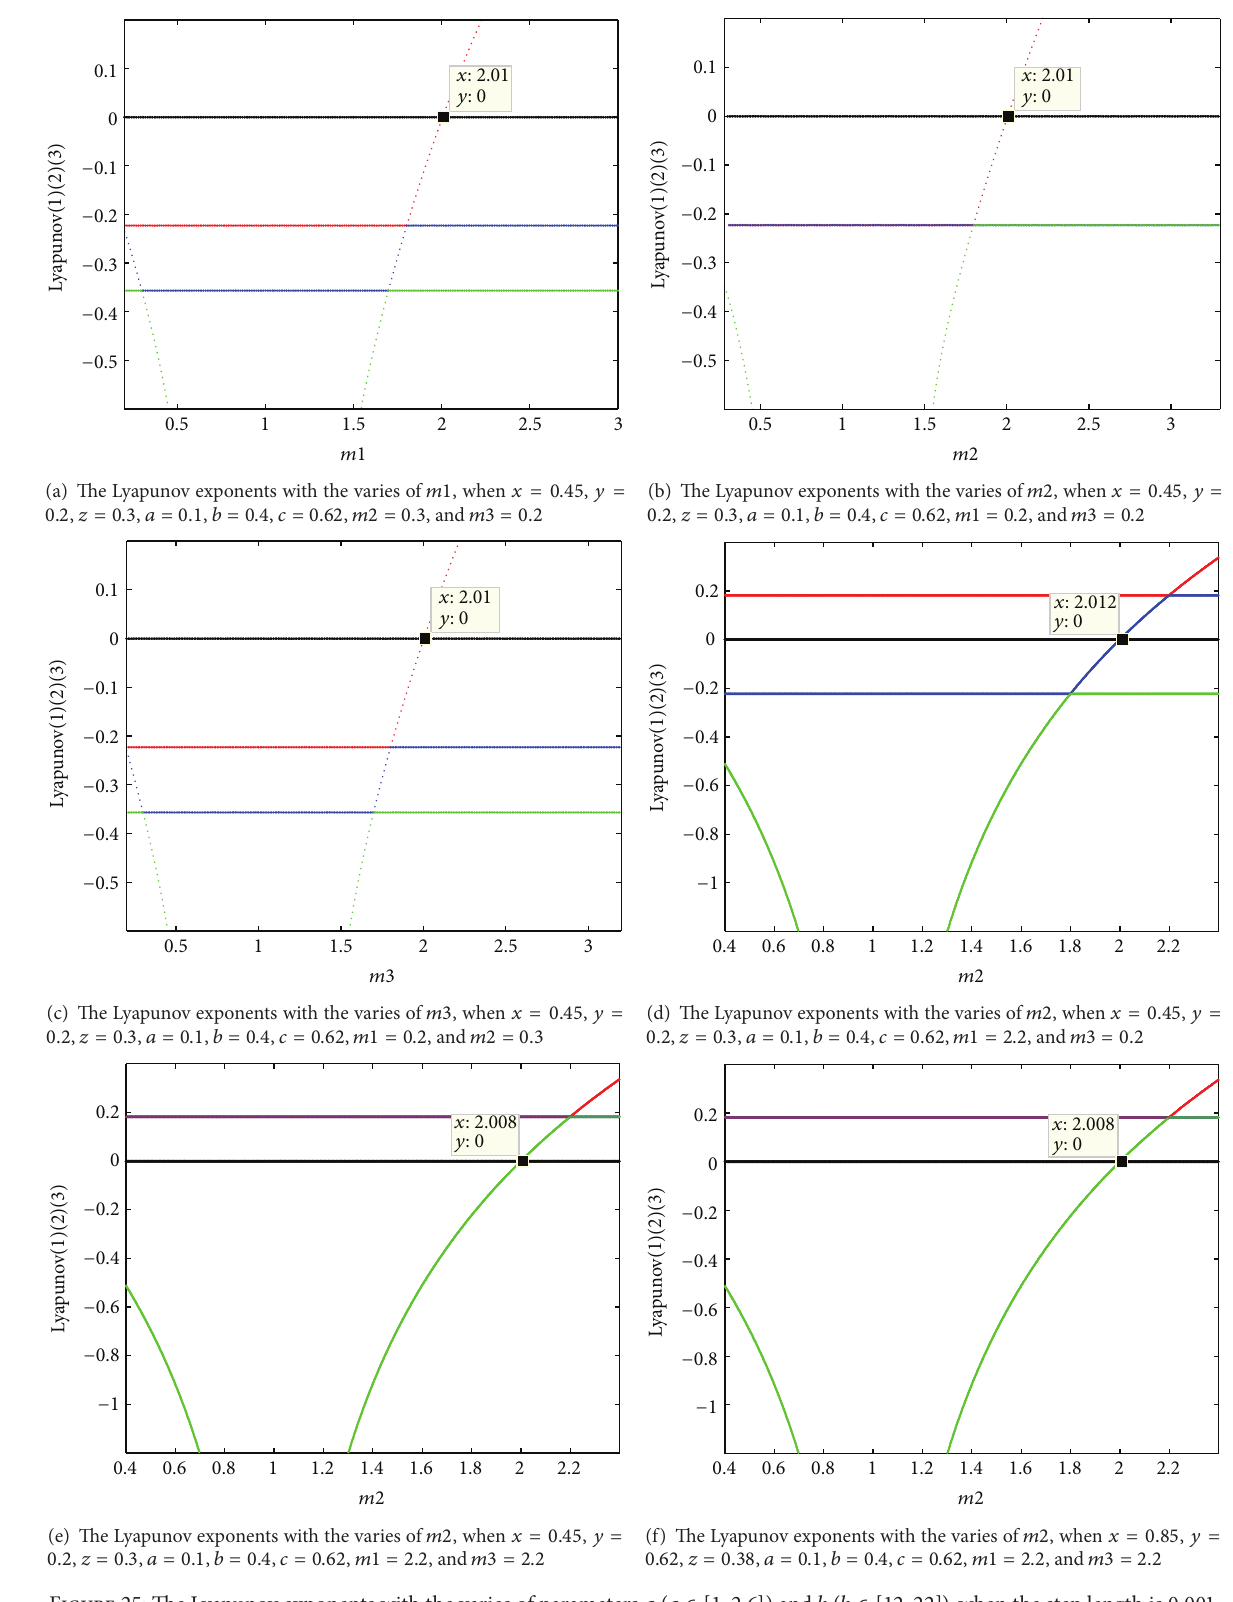
Figure 25: The Lyapunov exponents with the varies of parameters 𝑎 ( 𝑎 ∈ [1, 2.6] ) and 𝑏 ( 𝑏 ∈ [12, 22]) when the step length is